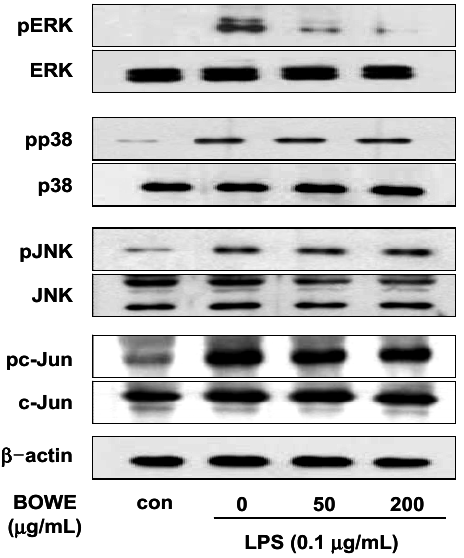
Figure 6. Effect of BOWE on MAPK phosphorylation in LPS-stimulated BV-2 cells: BV-2 cells were pretreated with or without the indicated concentrations of BOWE for 4 h and then stimulated with LPS (0.1 μ g/mL) for 18 h. The cellular proteins from the cells were used for the detection of phosphorylated or total forms of ERK1/2, p38 MAPK, JNK1/2, and c-Jun by western